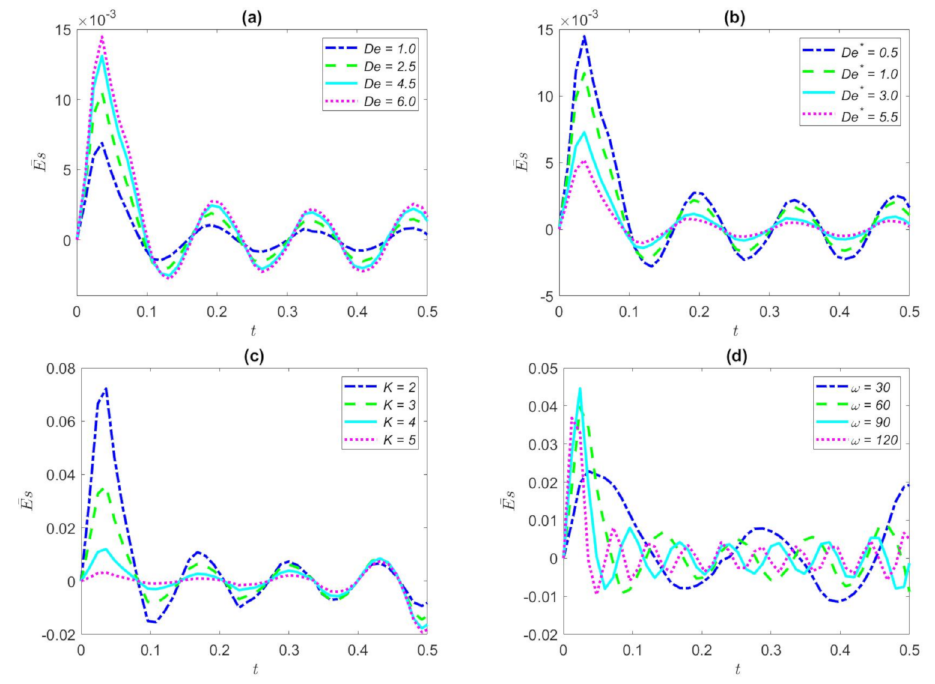
Figure 7. Effects of the dimensionless streaming potential of the triangular waveform for some values of De , De * , K , ω . ( a ) De * = 0.5, ϕ = 2%, ω = 45, Ha = 2, K = 2; ( b ) De = 6, ϕ = 2%, ω = 45, Ha = 2, K =